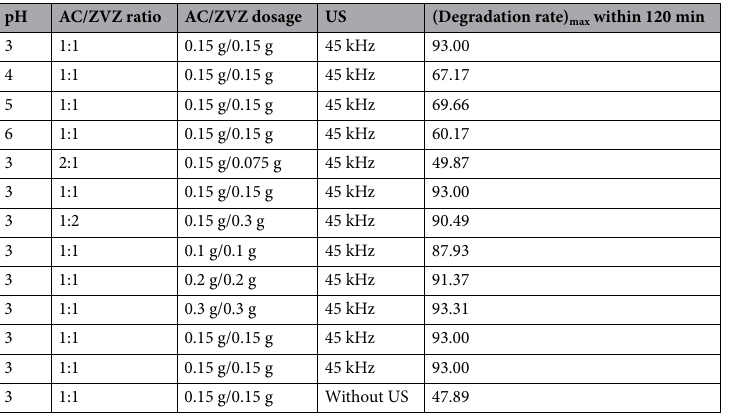
Table 1. Results of [C 4 mim][BF 4 ] degradation in US-ZVZ/AC system under the different conditions. [C 4 mim]